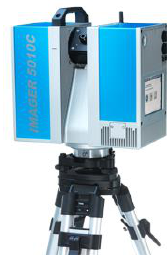
maximum distance 187m minimum distance 0.3m resolution